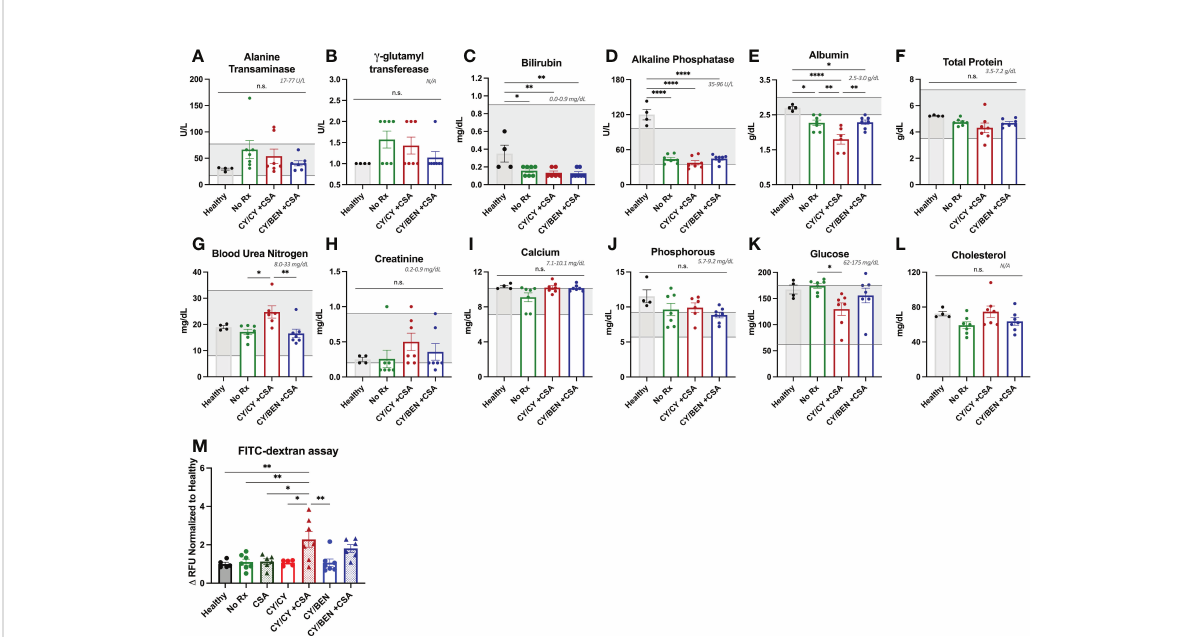
FIGURE 3 Combination CY/CY +CSA treated animals have signi fi cantly reduced plasma albumin and increased intestinal permeability at day 10 post-PBMC infusion. (A-L) Plasma was collected at day 10 from healthy untreated NSG mice (healthy), NSG mice that were conditioned with 150 cGy of radiation, infused with PBMCs and received no pharmacological agents (no Rx), or those treated with CY/CY +CSA or CY/BEN +CSA. A comprehensive metabolic panel was performed to evaluate potential toxicities from treatment or metabolic alterations indicative of GvHD. Gray numbers and shaded gray areas illustrate the normal range for mice of each given analyte on each graph. (M) Plasma was isolated from fasted mice before and 4-hours-post oral gavage of FITC-dextran to evaluate intestinal integrity. Values were calculated as a change in relative fl uorescence units (RFU) and were normalized to the average values of healthy NSG mice on each day of analysis. (A-M) A one-way ANOVA with Tukey ’ s post-hoc comparisons was used to determine signi fi cant differences between treatments. P values are indicated by the number of asterisks between groups noted on graphs, *<0.05, **<0.01, ****<0.0001, n.s.= not signi fi